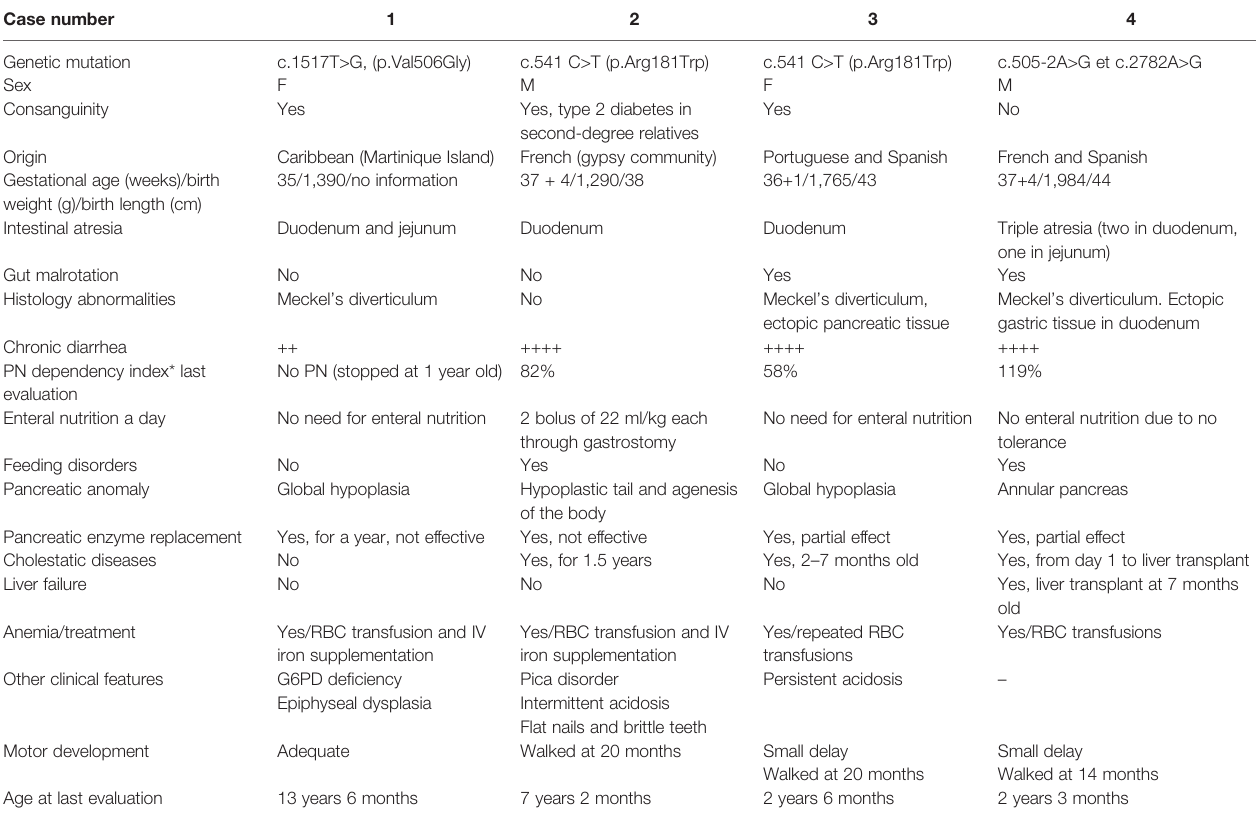
TABLE 1 | Clinical characteristics of four reported